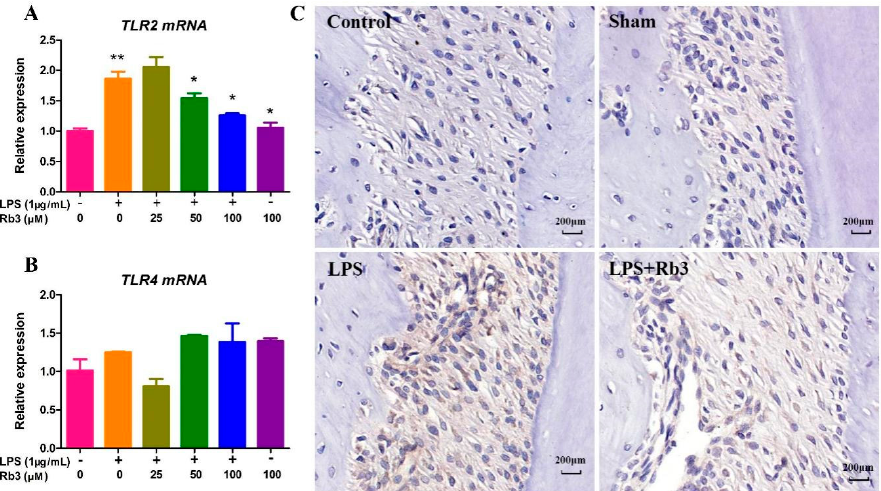
Figure 5. Rb3 inhibits chronic inflammation by downregulating expression of TLR2. ( A , B ) The relative levels of TLR2 and TLR4 mRNA (4 days) in HPLCs were examined by qPCR. ( C ) Expression of TLR2 in periodontal tissues of rat was detected by IHC analysis. Scale bar represents 20 μ m. All data were presented as means ± SE (n = 3). SE, standard error. * p < 0.05 significantly different from LPS stimulation only group. ** p < 0.05 compared with normal control.